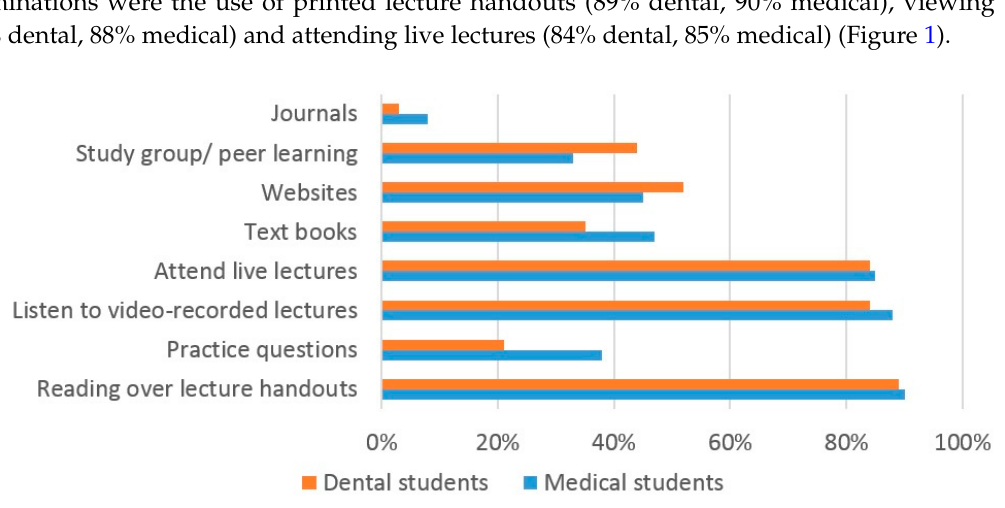
Figure 1. The methods used by dental and medical students to prepare for an examination.